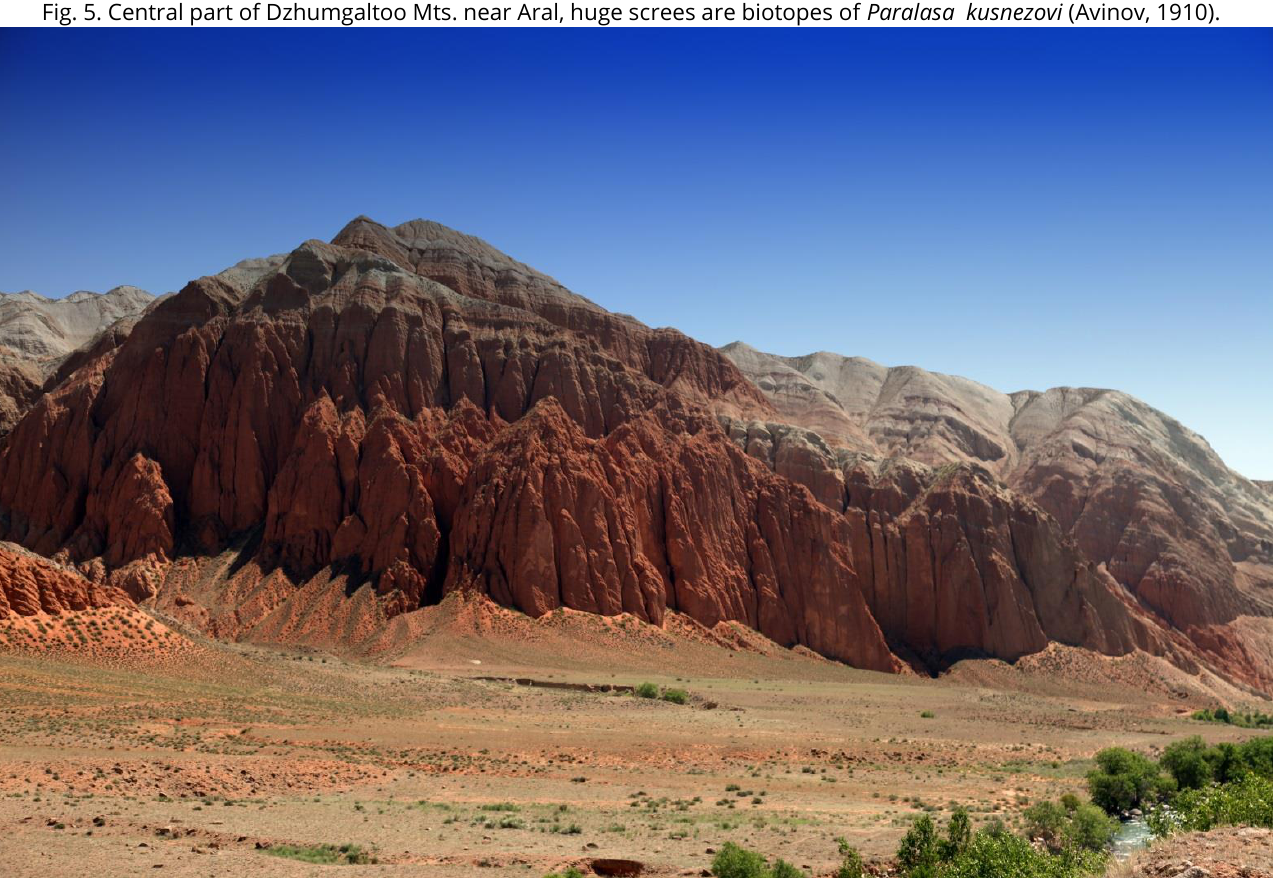
Fig. 6. Eastern part of Dzhumgaltoo Mts. near Chaek, dry mountains. Typical biotope of various Hyponephele species, Melitaea sibina and some Lycaenidae ( Athamanthia dilutior, Alpherakya sarta